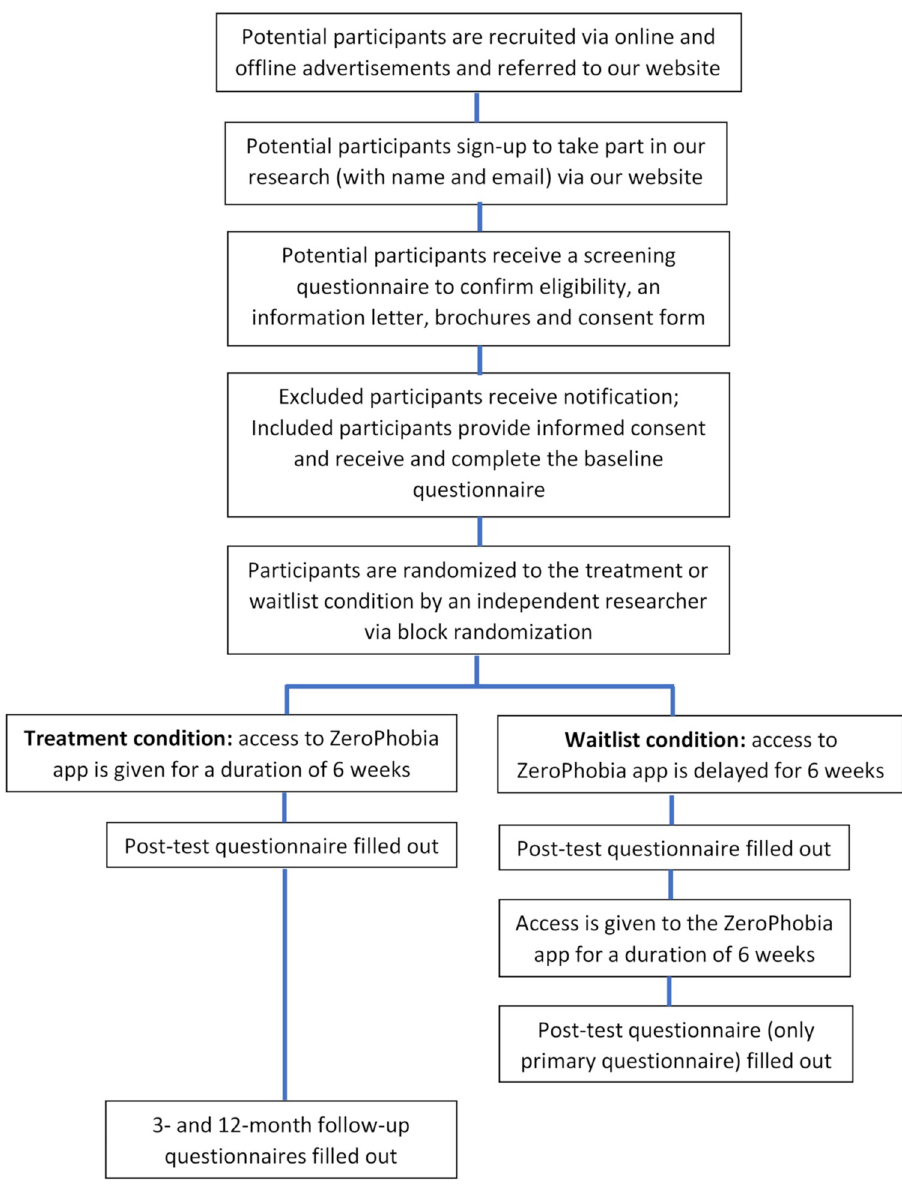
Fig 2. Participant flow